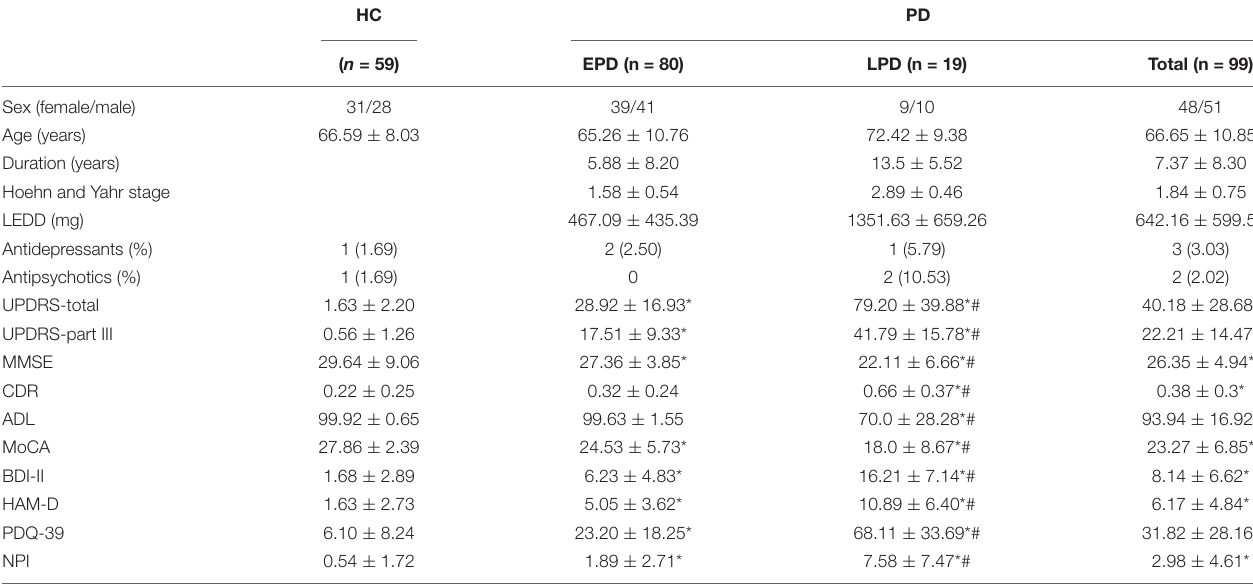
TABLE 1 | Clinical characteristics of patients with Parkinson’s disease (PD) in early (EPD) and late (LPD) stages, and healthy controls